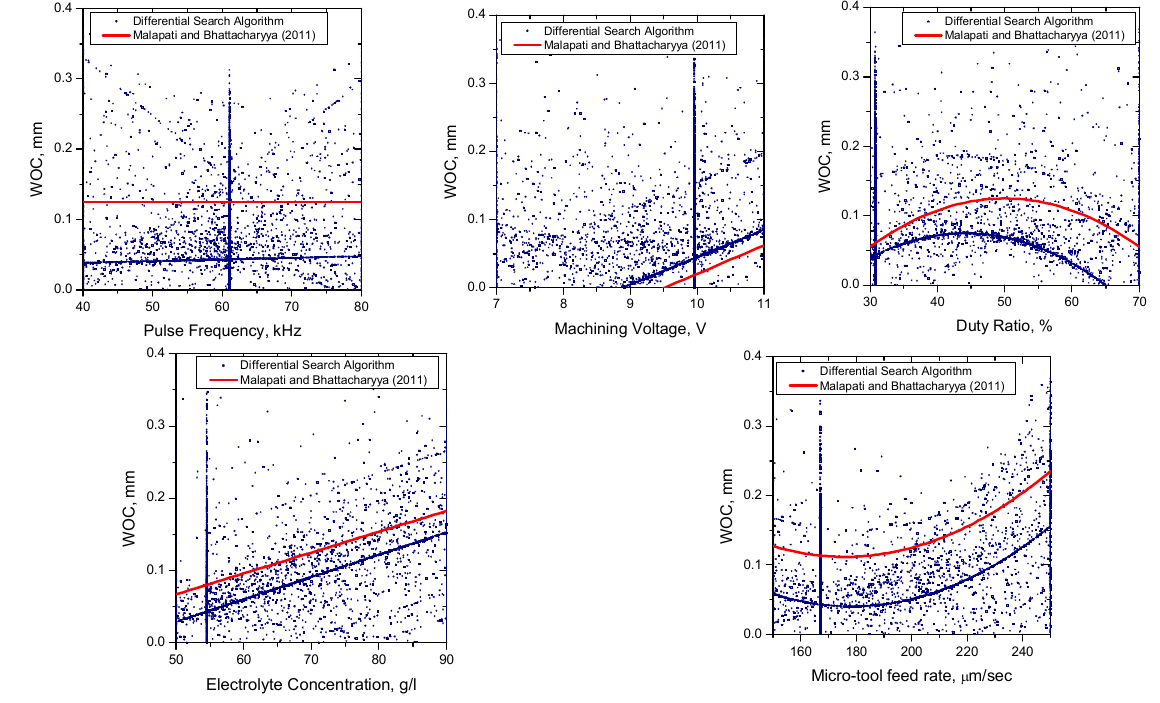
Fig. 3. Variations of WOC for different EMM process